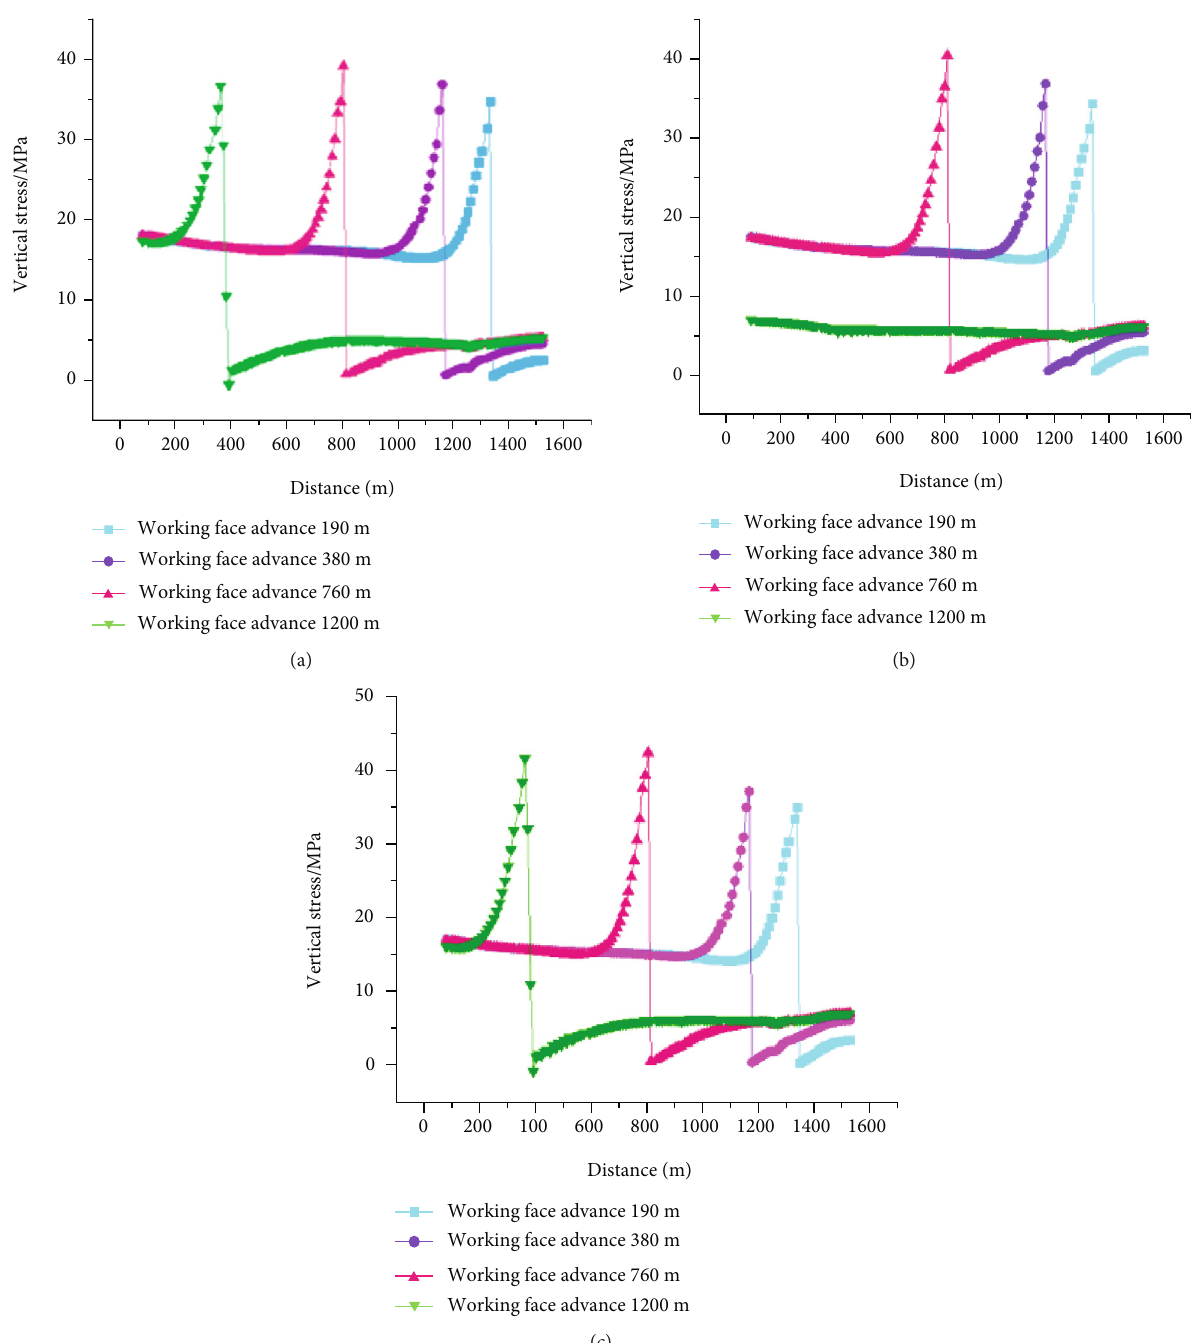
Figure 11: Vertical stress change in di ff erent working face widths: (a) 250 m, (b) 300m, and (c)